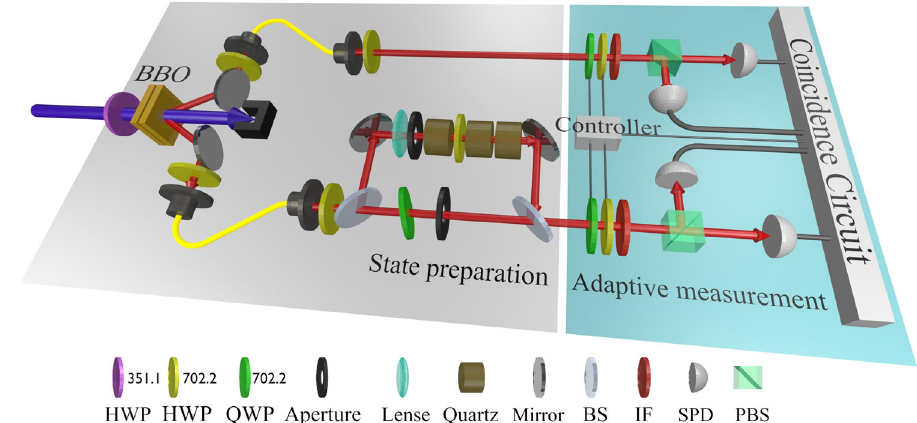
Fig. 3 Experimental setup. The experimental setup can be divided into two modules: state preparation ( gray ) and adaptive measurement ( light blue ). In state preparation module, arbitrary Werner states ρ W ( p ) in can be generated. In adaptive measurement module, the two-photon product measurements are realized and can be adaptively changed by a Labview program. Key to components: HWP, half-wave plate; QWP, quarter-wave plate; BS, beam splitter; IF, interference fi lter; SPD, single photon detector; PBS, polarizing beam